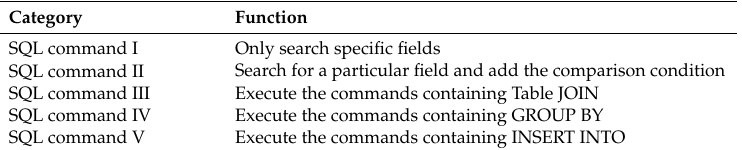
Table 2. Test SQL commands.